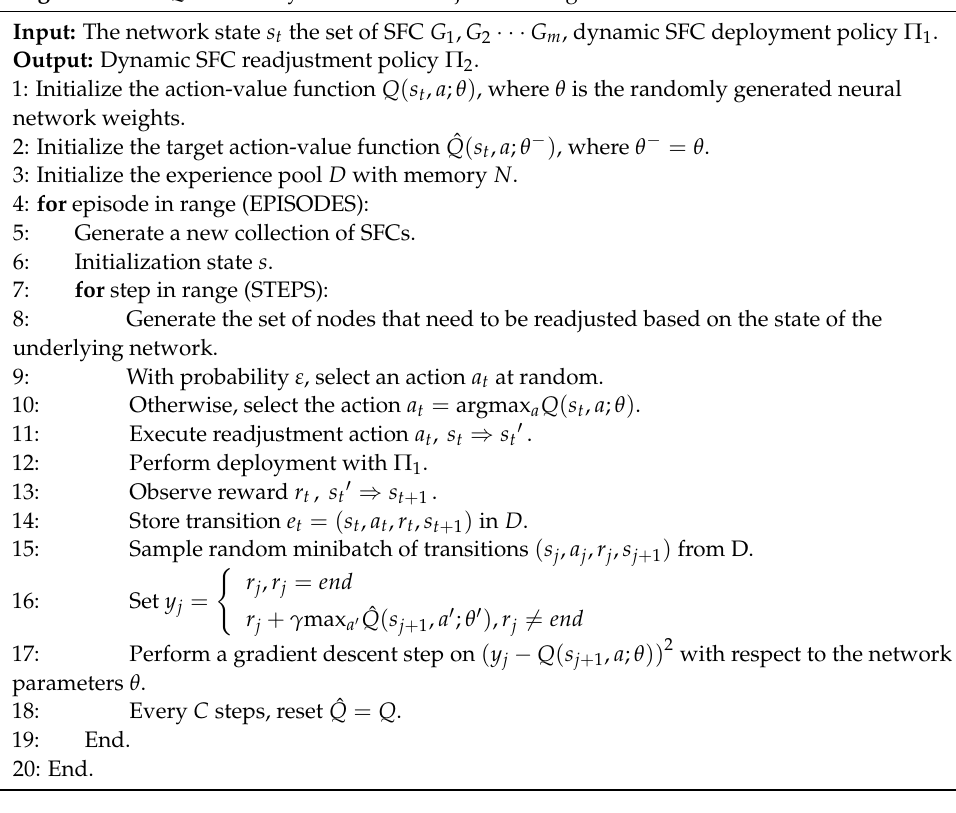
Algorithm 2: DQN-based dynamic SFC readjustment